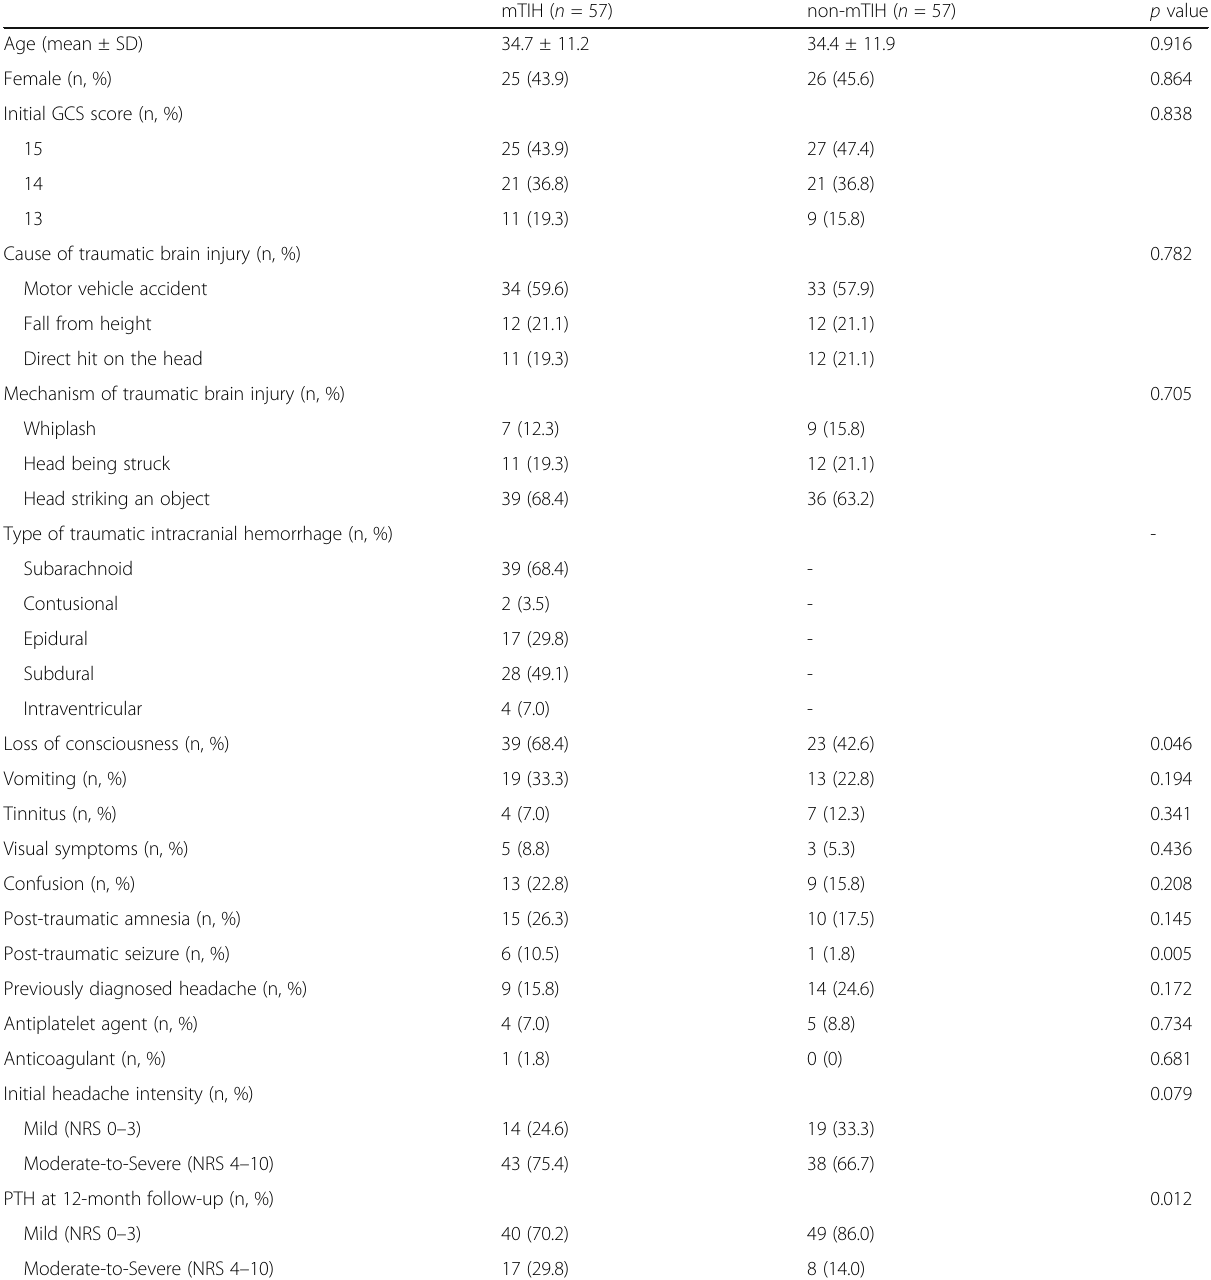
Table 1 Clinical characteristics of propensity score-matched subjects mTIH ( n = 57) non-mTIH ( n = 57) p value Age (mean ± SD) 34.7 ± 11.2 34.4 ± 11.9